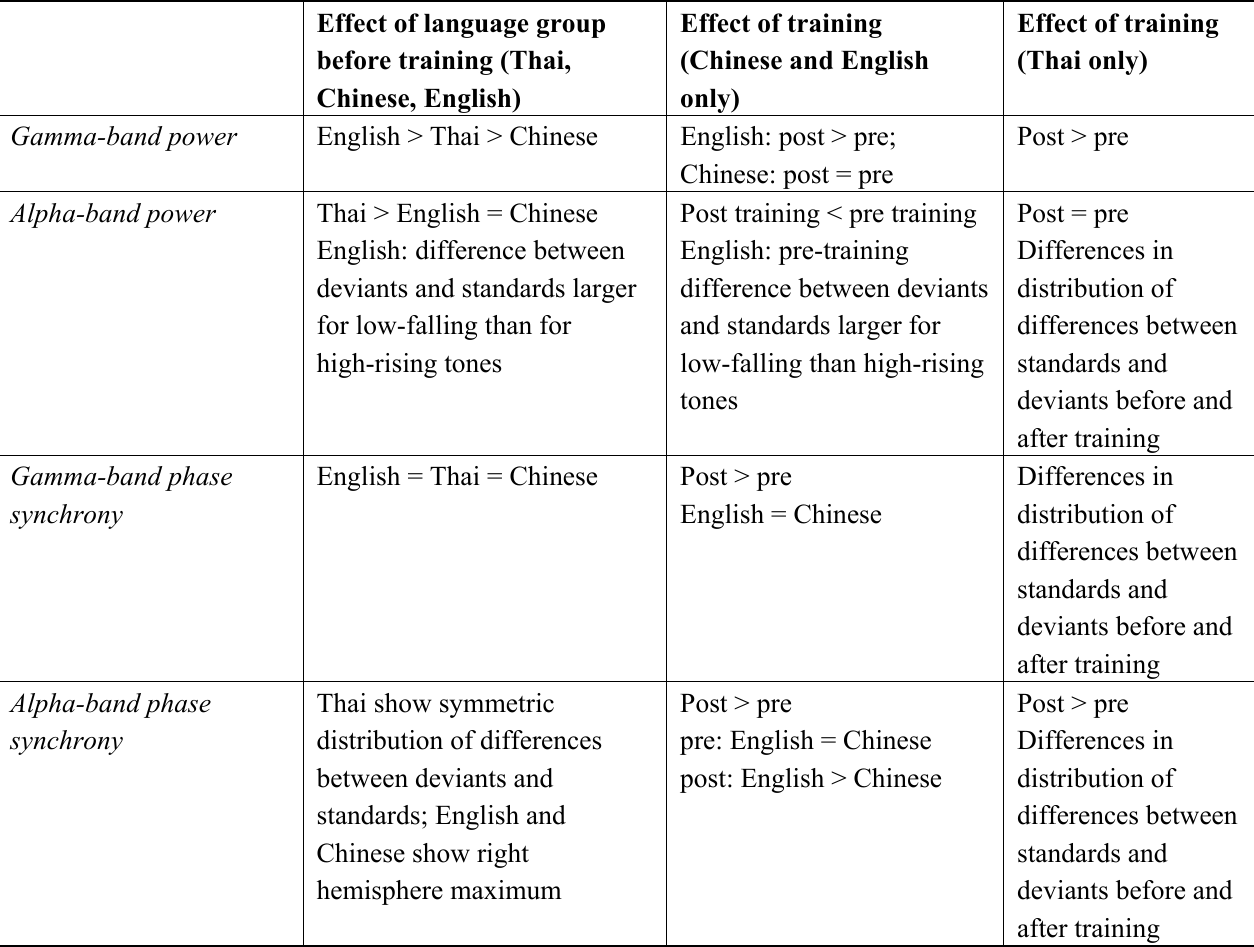
Table 2. Overview of the main findings; post = post training; pre = pre